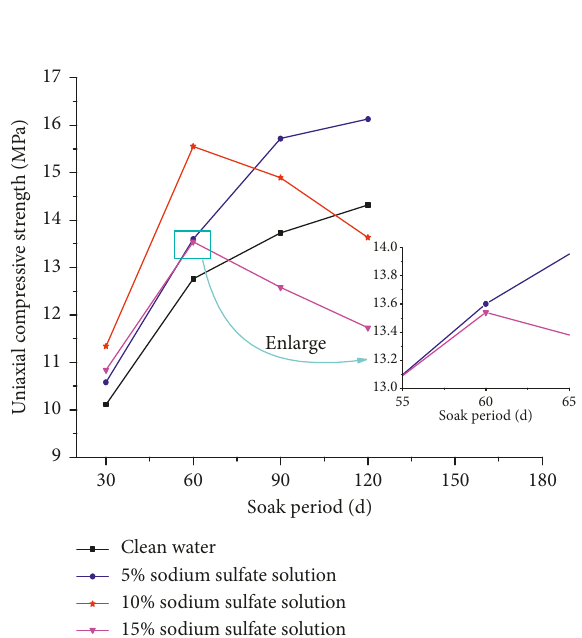
Figure 4: Effect of different concentrations of sulfate solution on the strength of filling